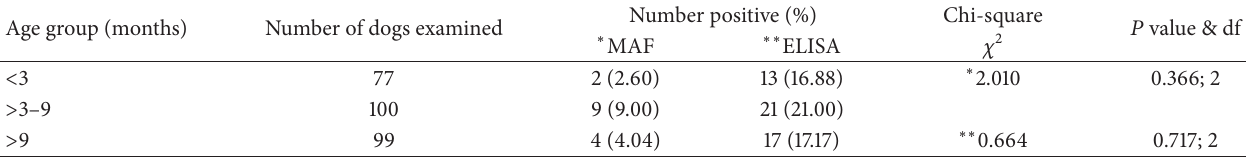
Table 2: Effect of age on the prevalence of Cryptosporidium infection in dogs using ELISA and MAF techniques in the FCT, Abuja. Age group (months)